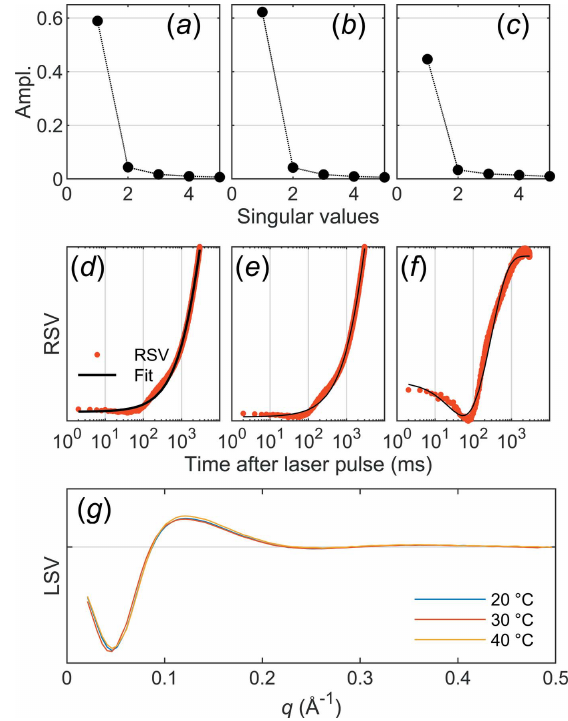
Figure 7 SVD analysis of lysozyme data. ( a – c ) Relative amplitude of the first five singular values from an SVD analysis of lysozyme data from a T-jump starting from 20 (cid:5) C ( a ), 30 (cid:5) C ( b ) and 40 (cid:5) C ( c ). ( d – f ) The first right singular vector (RSV), the temporal evolution of the signal, 20 (cid:5) C ( d ), 30 (cid:5) C ( e ) and 40 (cid:5) C ( f ). ( g ) The first left singular vector (LSV) at the three temperatures.